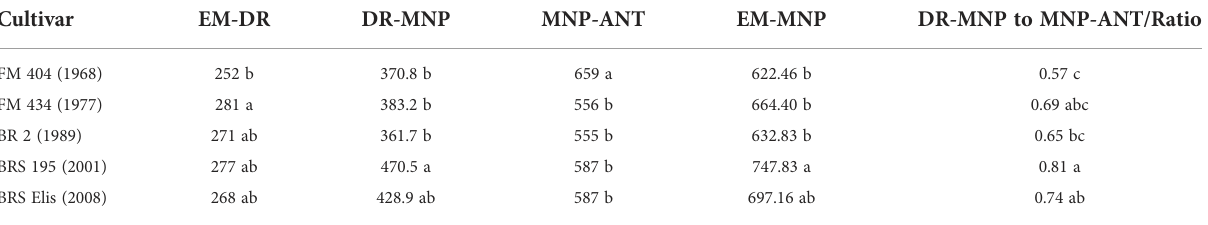
TABLE 3 Duration of the different phenological phases of barley cultivars released at different decades in Brazil: thermal times (° Cd) from emergence to double ridge (EM-DR); DR to the maximum number of primordium (DR-MNP); MNP to Anthesis (MNP-ANT) and DR-MNP to MNP- ANT ratio in 2011, 2012 and 2013 experiments (1)